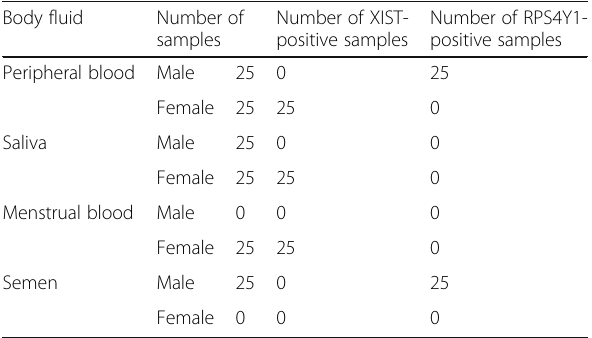
Table 4 Comparison between XIST mean values in the studied